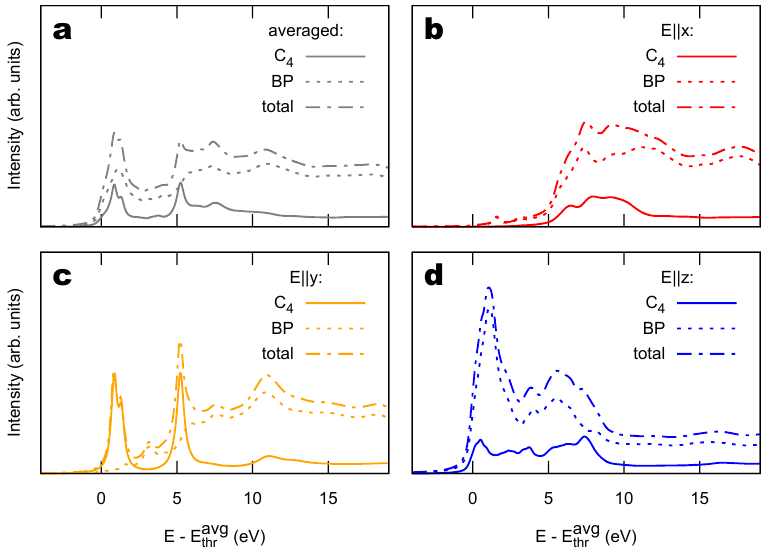
Figure 6. Decomposition of the NEXAFS spectrum of bBEBP/Au(111) into contributions by the sp 1 chain (C 4 ) and the sp 2 biphenyl group (BP). ( a ) Spectrum averaged over all polarizations. ( b ) In-plane electric field along the polymer axis x , and ( c ) orthogonal to it, y ; ( d ) out-of-plane z -directed electric field (see Figure 3a for the definition of x , y , z